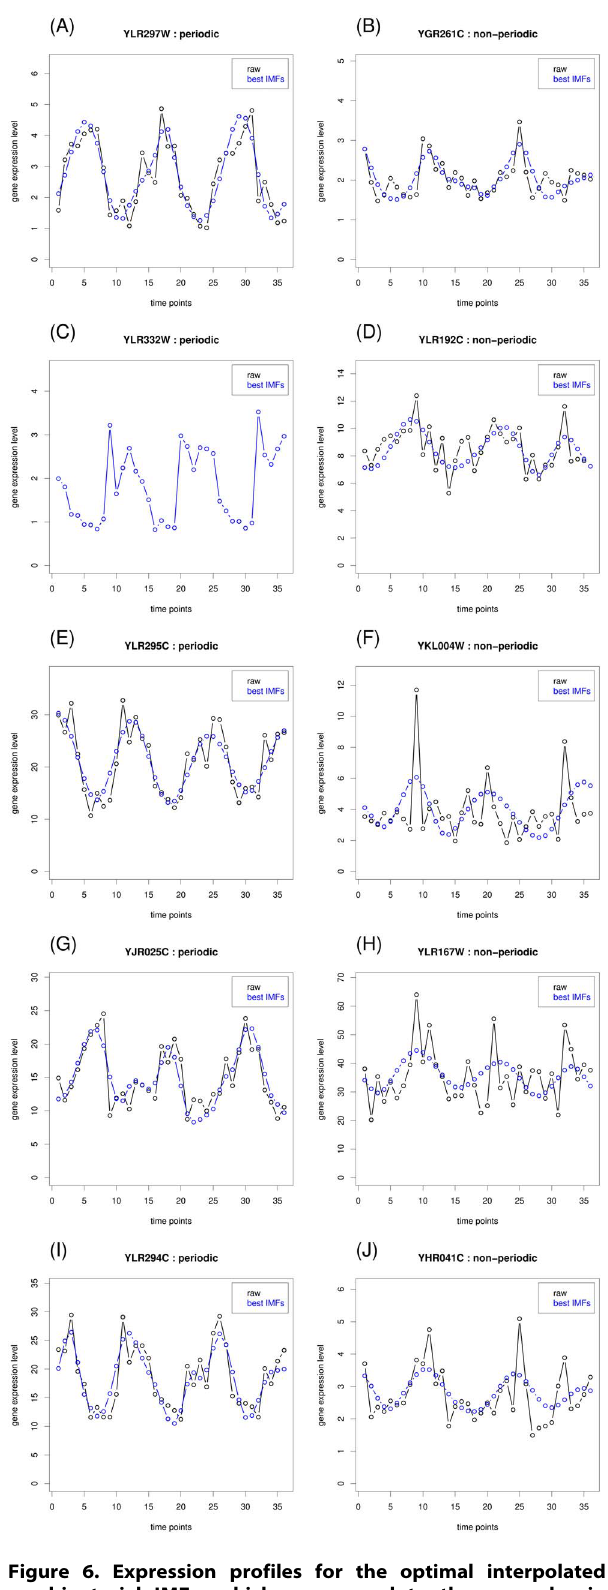
Figure 6. Expression profiles for the optimal interpolated combinatorial IMFs, which correspond to the examples in Figure 4. The left column presents the periodic probesets. The right column presents the non-periodic probesets.